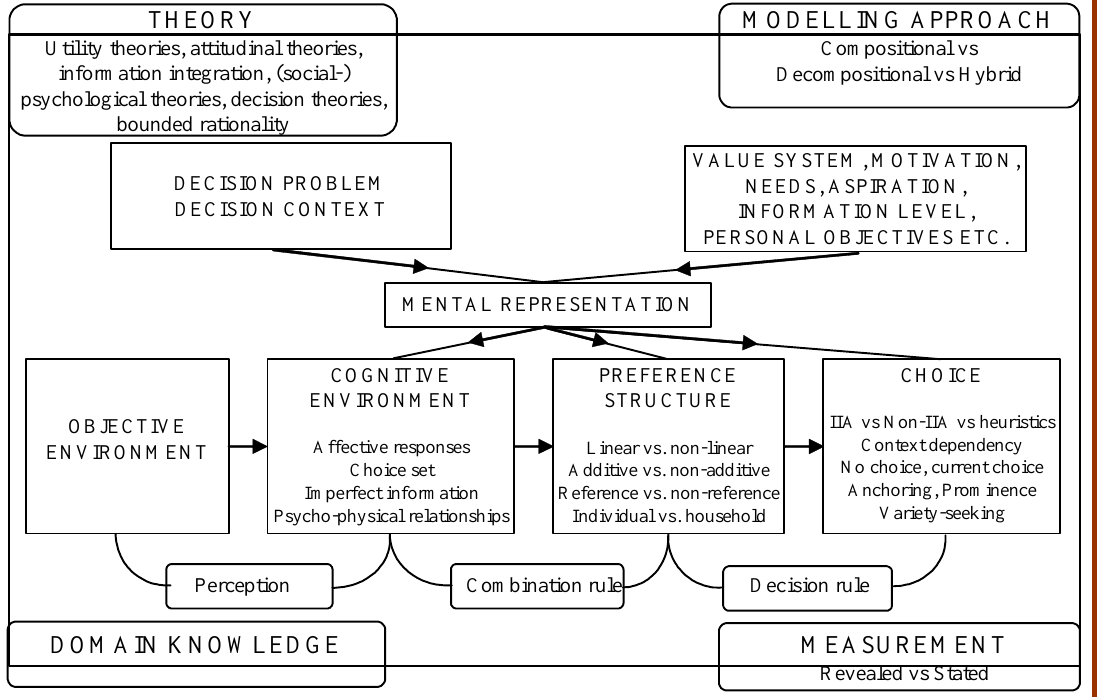
Figure 1. Conceptual framework and key topics in seminal behavioural analyses in